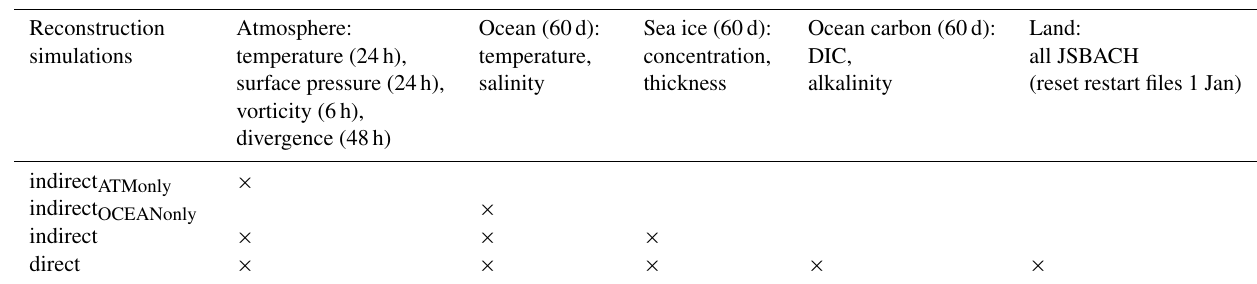
Table 1. Overview of different reconstruction simulations. The first column title marks the labels of the experiments as used in the paper. The reconstruction strength of relaxation timescales is noted in brackets, where h denotes hours and d days. The land carbon cycle is not dynamically reconstructed at each time step but by a hard reset of restart files each 1 January from the target run. These land restart files include carbon and nitrogen pools, soil physics (moisture, temperature, snow cover), vegetation cover (plant functional types distribution) and canopy (leaf area